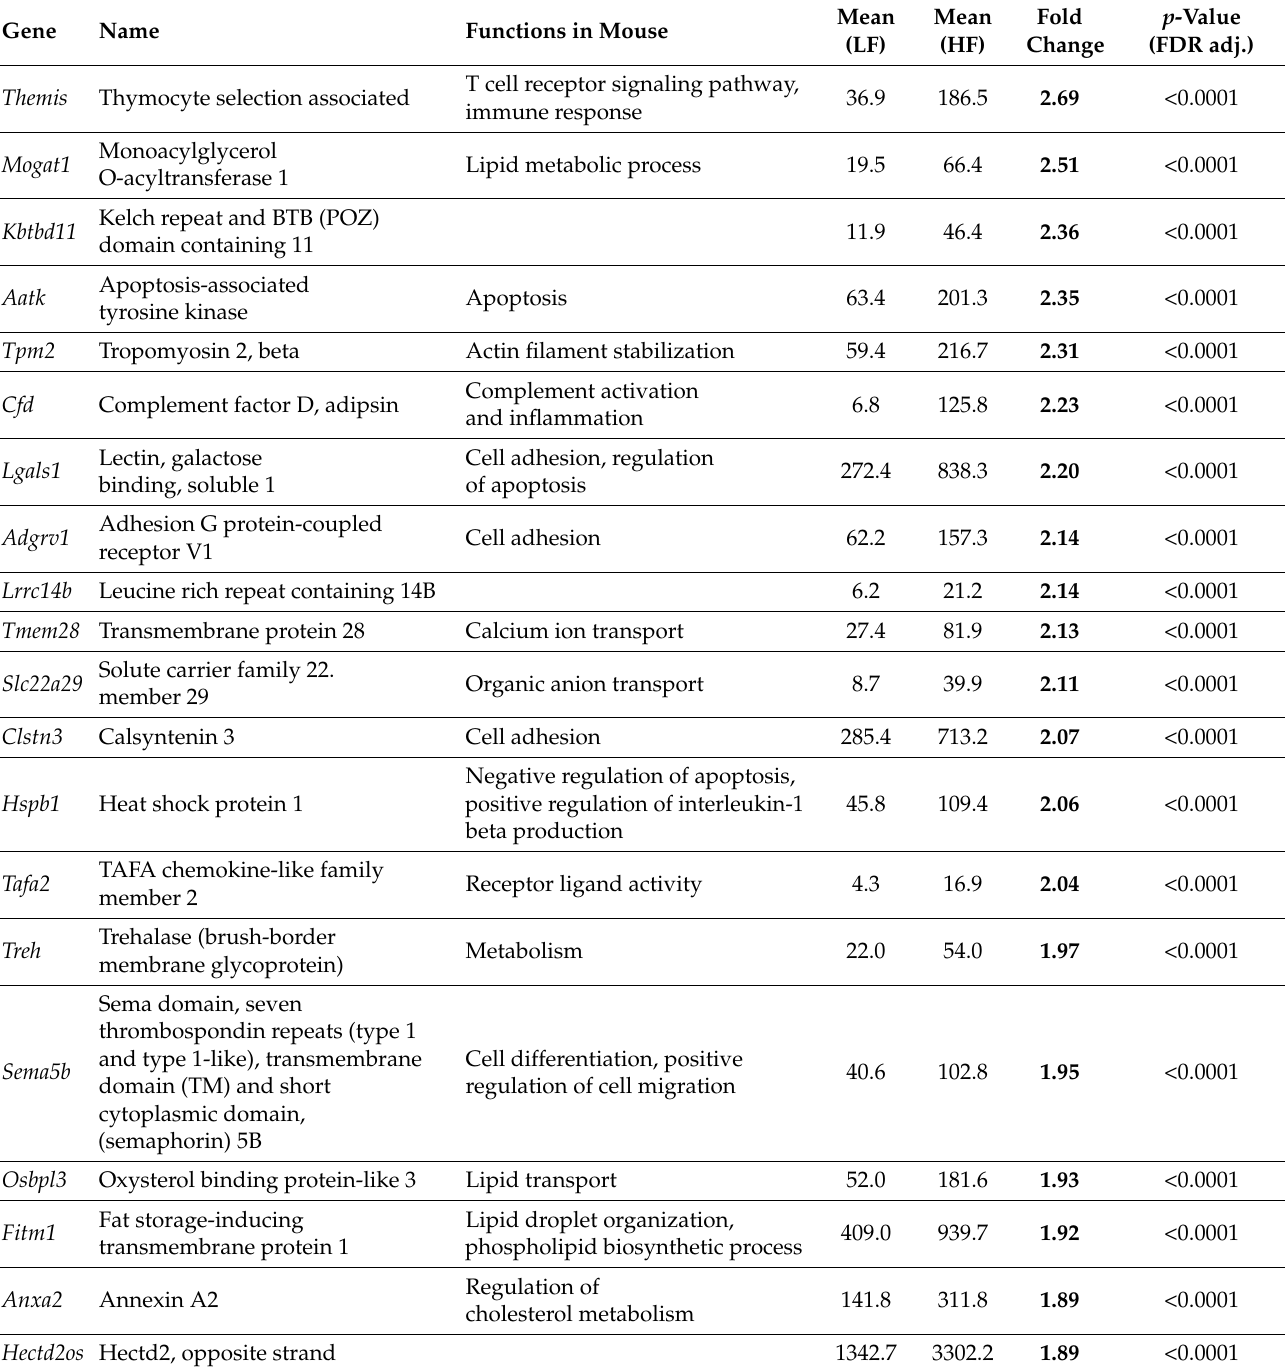
Table 1. The twenty most strongly upregulated genes in the high-fat (HF) diet group relative to the low-fat (LF) diet group. Mean expression levels are given as DESeq2-normalized counts. p -values are adjusted by false discovery rate